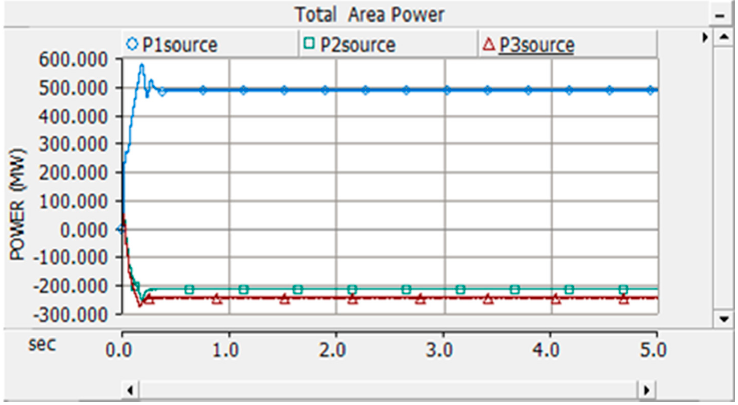
Figure 9. Total active power in area-1, area-2, and area-3.